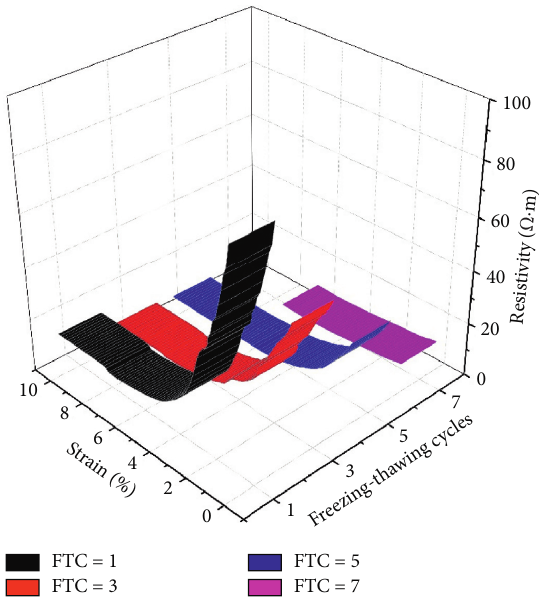
Figure 10: Resistivity-strain 3D ribbons of